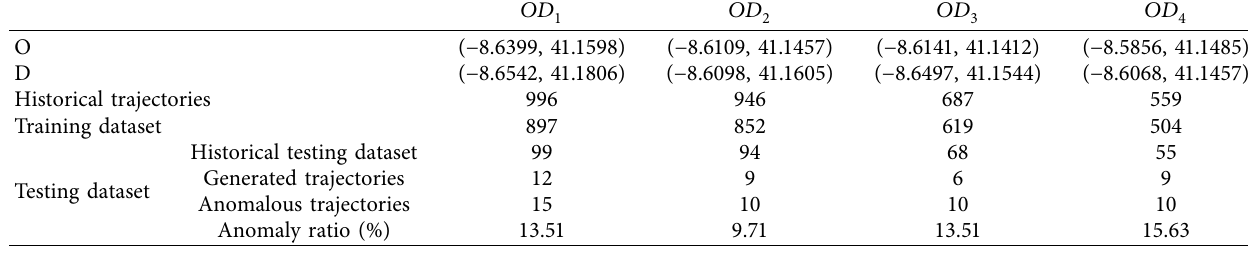
Table 1: The information on OD pairs.